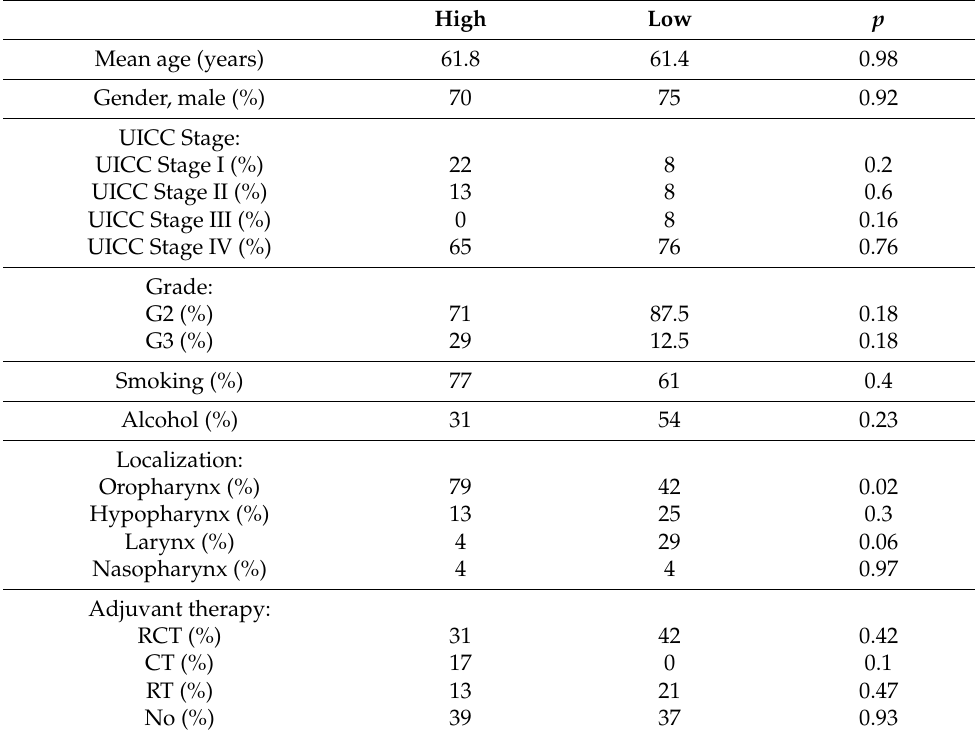
Table 3. Overview of the clinicopathological features of patients with high and low neutrophil infiltrations in the B cell zones of